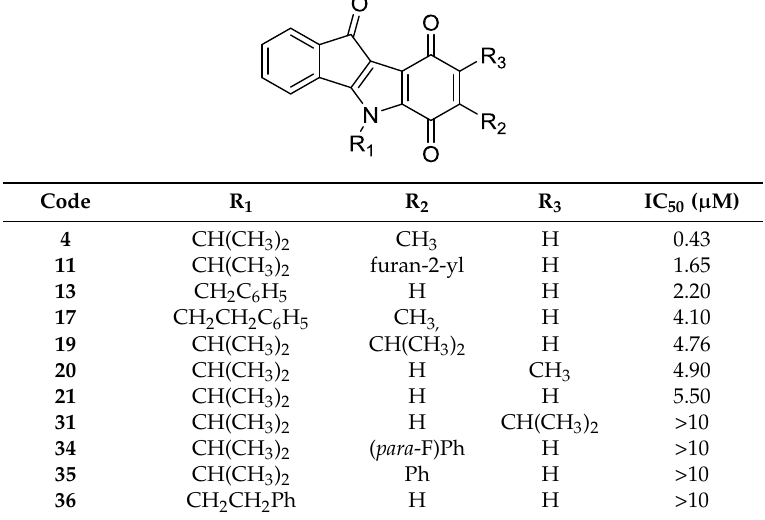
Table 3. Structures of the quinonic indeno[1,2- b ]indoles and their IC 50 values towards CK2, which were used for the training and test sets, data from Alchab et al. [9], Gozzi et al. [12].